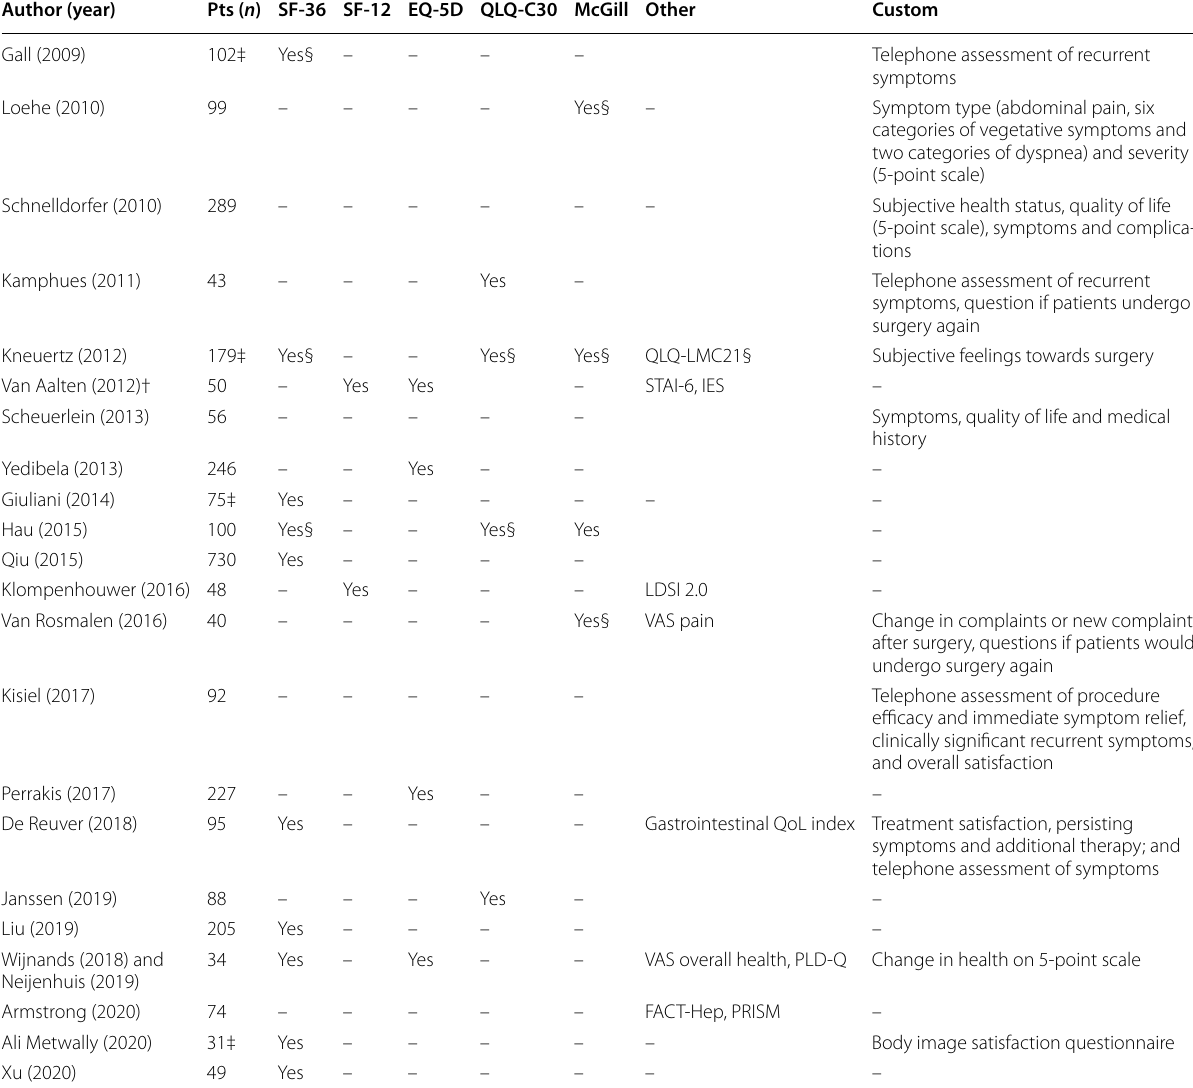
Table 2 Candidate PROMs for patients with BLTC identified by systematic literature